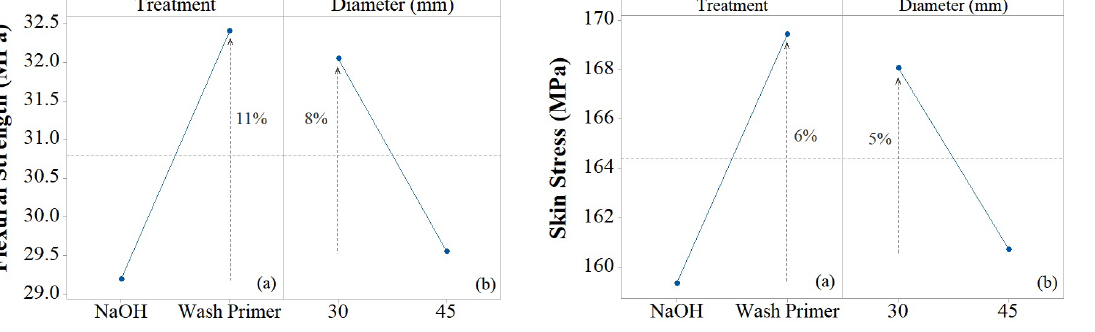
Figure 10. Main effect plot for the mean skin